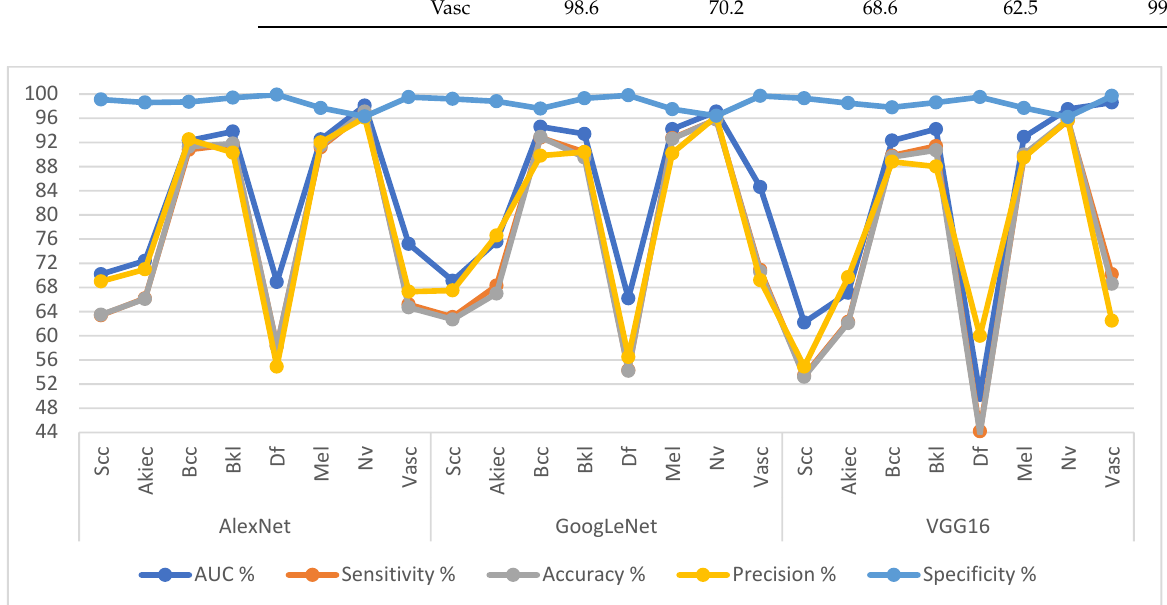
Figure 8. Display Performance results of CNN models based on ROI using the GAC method for early diagnosis and distinction of skin cancer and other skin lesions.